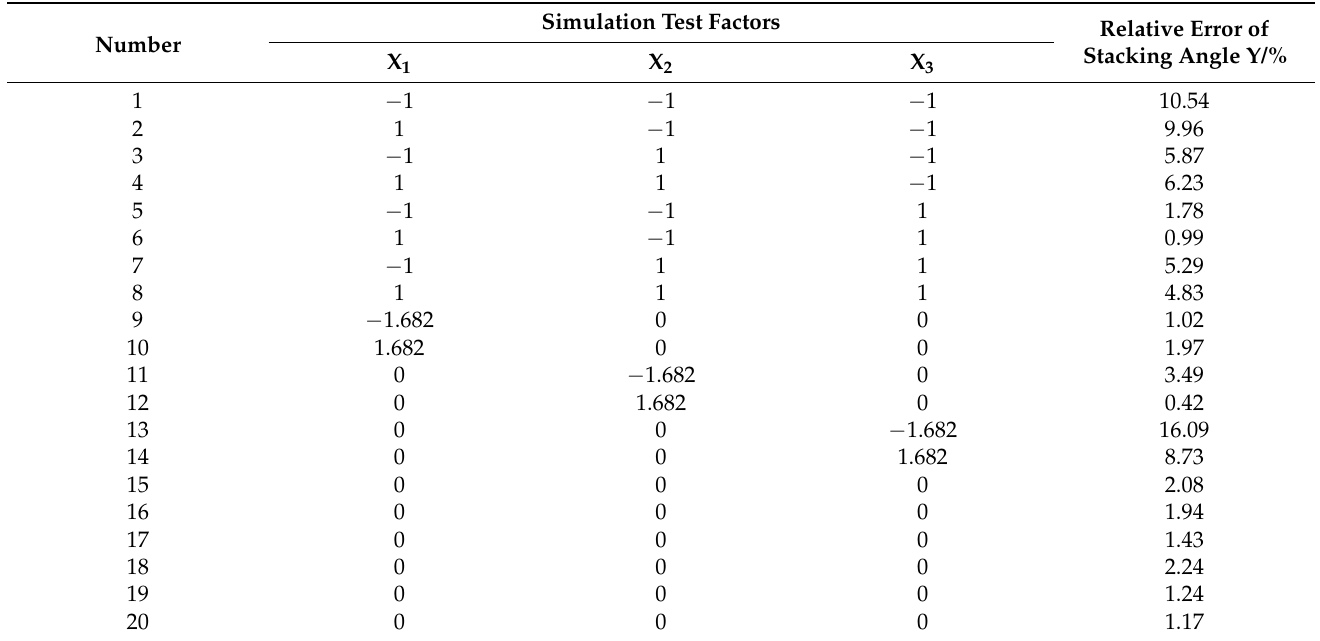
Table 8. Experiment scheme and results.